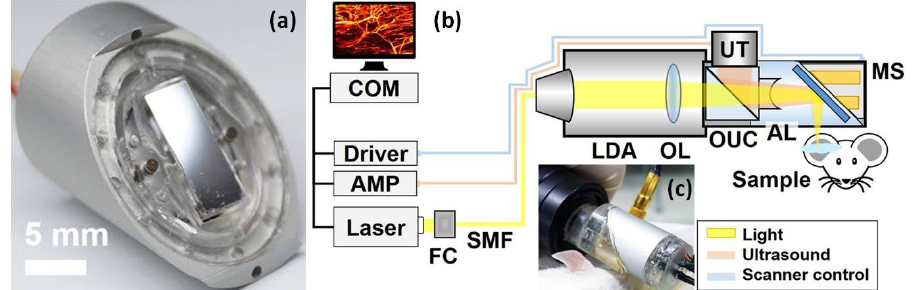
Figure 5. Handheld photoacoustic microscopy (PAM) probe. ( a ) Electromagnetic scanner. ( b ) Schematic